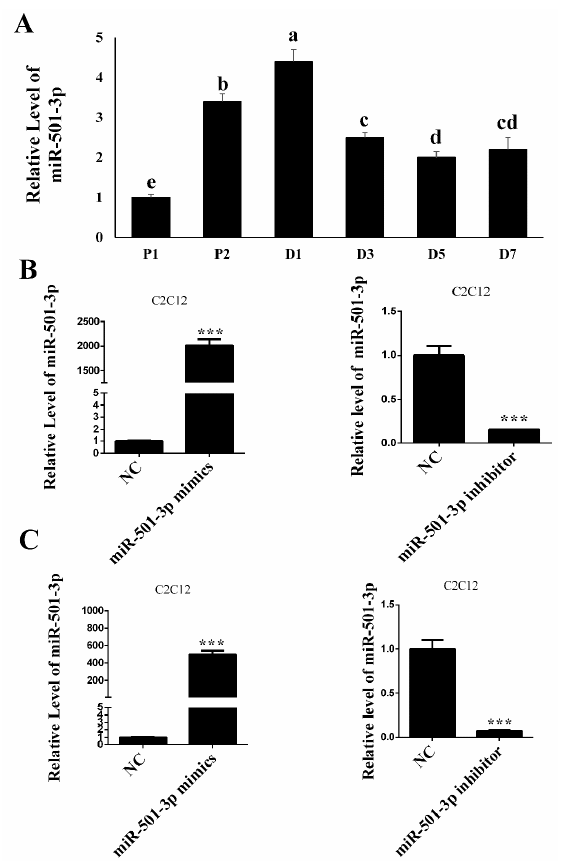
Figure 1. The miR-501-3p level in C2C12. ( A ) miR-501-3p levels at di ff erent stages of C2C12 myogenic development. ( B ) On the C2C12 proliferation day 1, miR-501-3p was elevated or inhibited by the miR-501-3p mimics or inhibitor, respectively. ( C ) On di ff erentiation day 7, miR-501-3p was elevated or inhibited by the miR-501-3p mimics or inhibitor, respectively. NC is the negative control for the miR-501-3p mimics or inhibitor. P1: proliferation day 1, D1: di ff erentiation day 1. In Figure 1A, bars with di ff erent letters indicate they are statistically di ff erent ( p < 0.05). *** p < 0.001. The results are presented as mean ± S.E.M. of three replicates for each treatment and control.